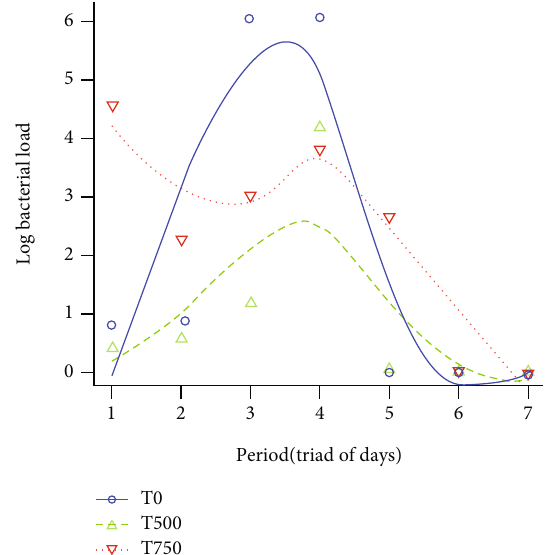
Figure 4: Bacterial load after oral inoculation of broiler chicken with Salmonella typhimurium . T : concentration 10 6 CFUs de Salmonella 0 typhimurium +0 A. galli ; T : concentration 10 6 CFUs de 500 Salmonella typhimurium +500 A. galli ; T : concentration 10 6 750 CFUs de Salmonella typhimurium +750 A. galli